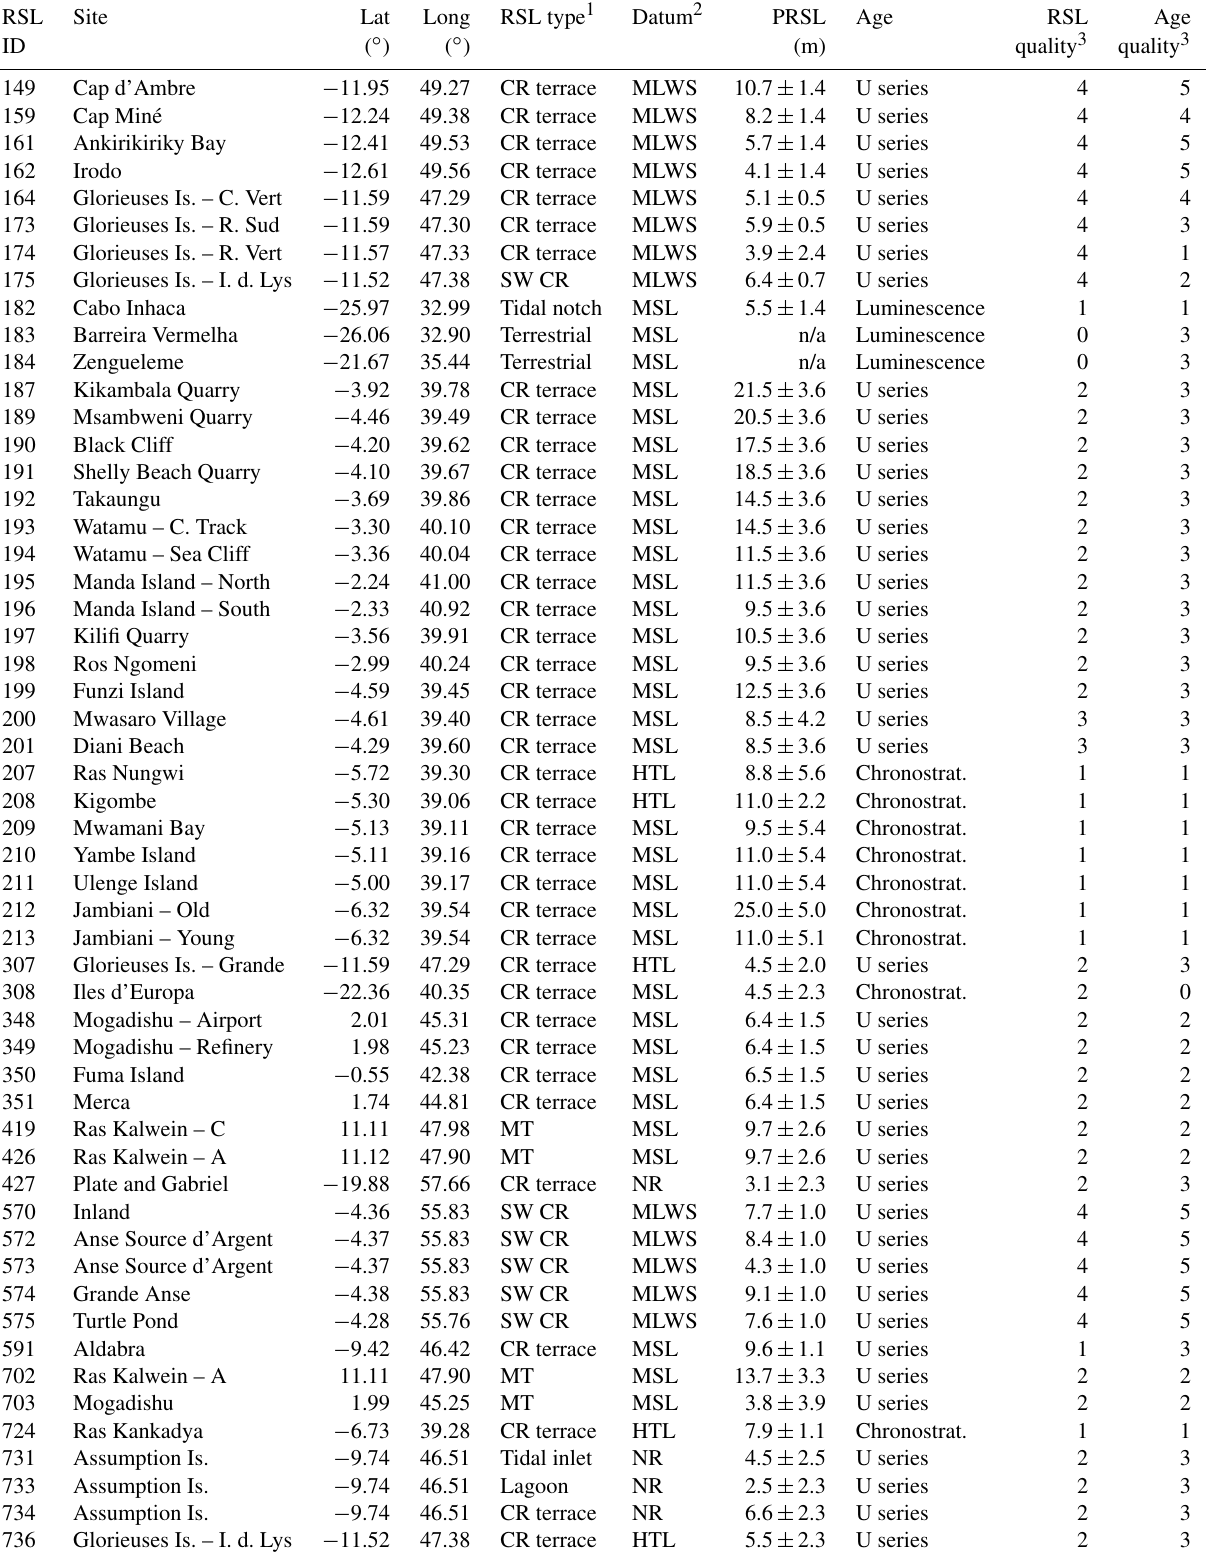
Table 6. Summary of RSL proxies and terrestrial-limiting points included in the WALIS